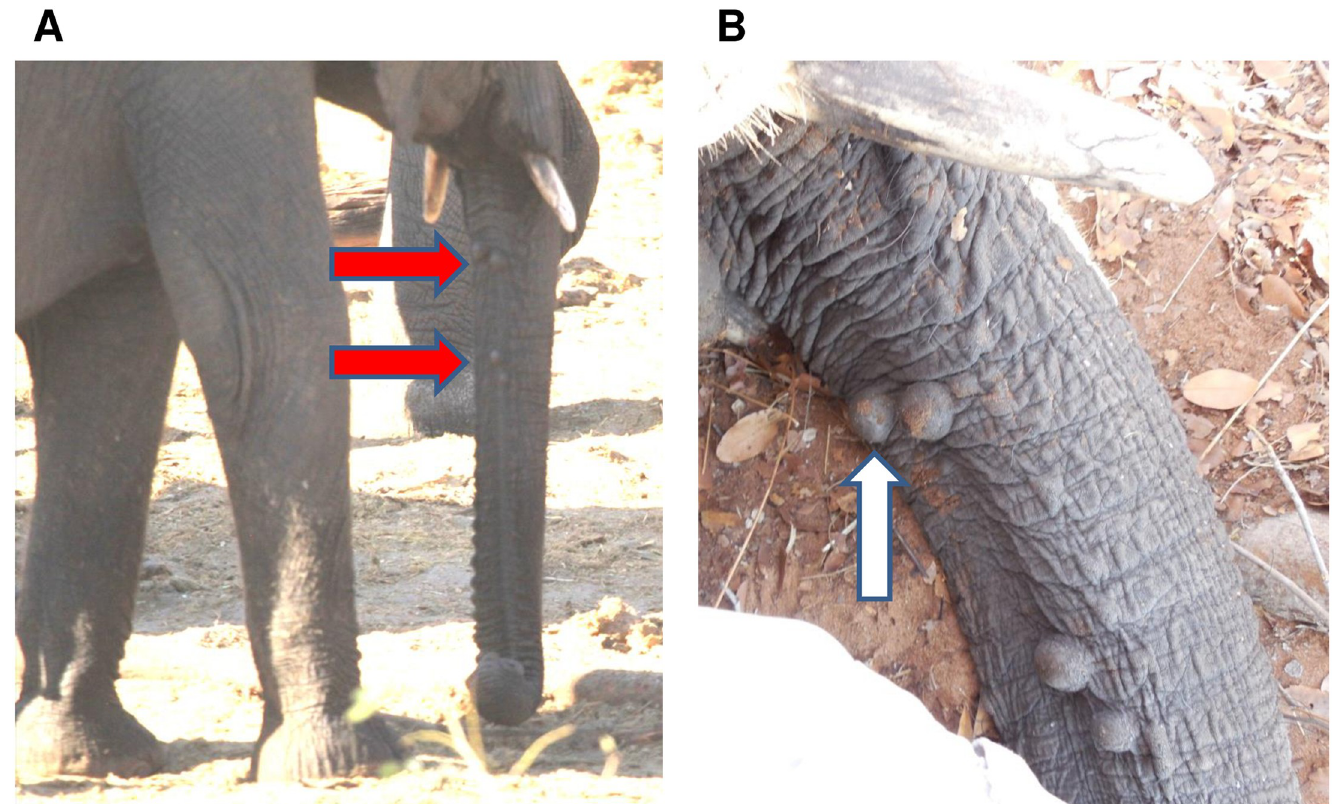
Fig 1. Nodule location. Trunk location (A) and gross appearance (B) of nodules present on a wild juvenile African elephant in Botswana (BW1 Male NOD 1–4). Samples collected under Elephants Without Borders Botswana Research Permit/ \#WT8/36/4XV(41). Location: Kalwesi Water Hole, Chobe National Park, Botswana. Red arrows indicate nodular position on the trunk; white arrow indicates the nodule from which the DNA was extracted to create the recombinant plasmid.